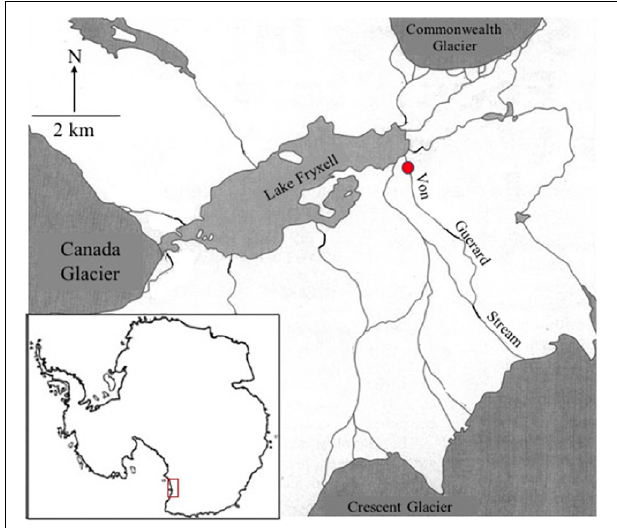
FIGURE 2 | Reference map of the sampled McMurdo Dry Valleys (MDV), Antarctica (red box, lower left ). Sample site a Von Guerard Stream is marked with a red